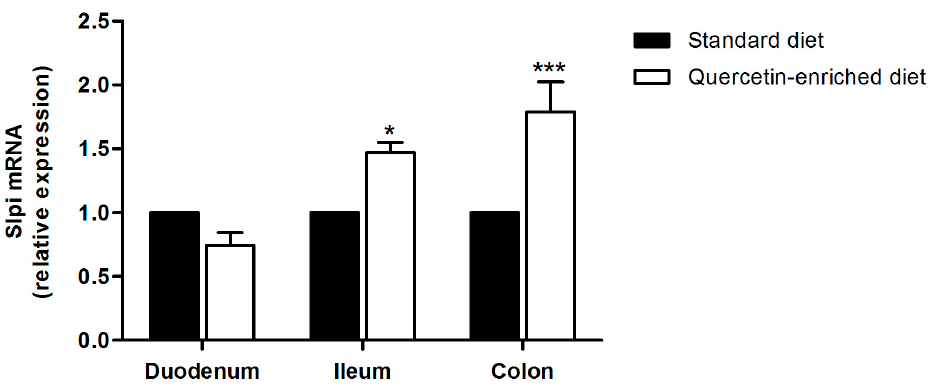
Figure 3. Quercetin induces Slpi expression in the ileum and colon. Quercetin-enriched or standard diet was administered for 4 weeks. Slpi expression was measured by qPCR in the small intestine or colon of standard (black bars) and quercetin (white bars) fed mice. Bars represent mean expression ± SEM ( n = 3) for each treatment. *** p < 0.001, * p < 0.05.